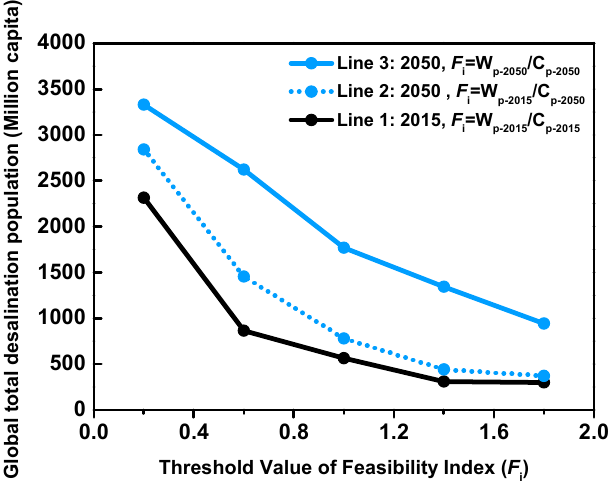
Figure 7. Sensitivity analysis of the feasibility index with respect to the total global desalination population for the base year of 2015 (Line 1), 2050 (assuming a constant water price. Line 2), and 2050 (assuming a changed water price, Line 3).